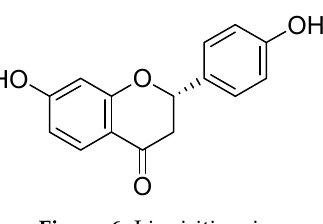
Figure 6. Liquiritigenin.